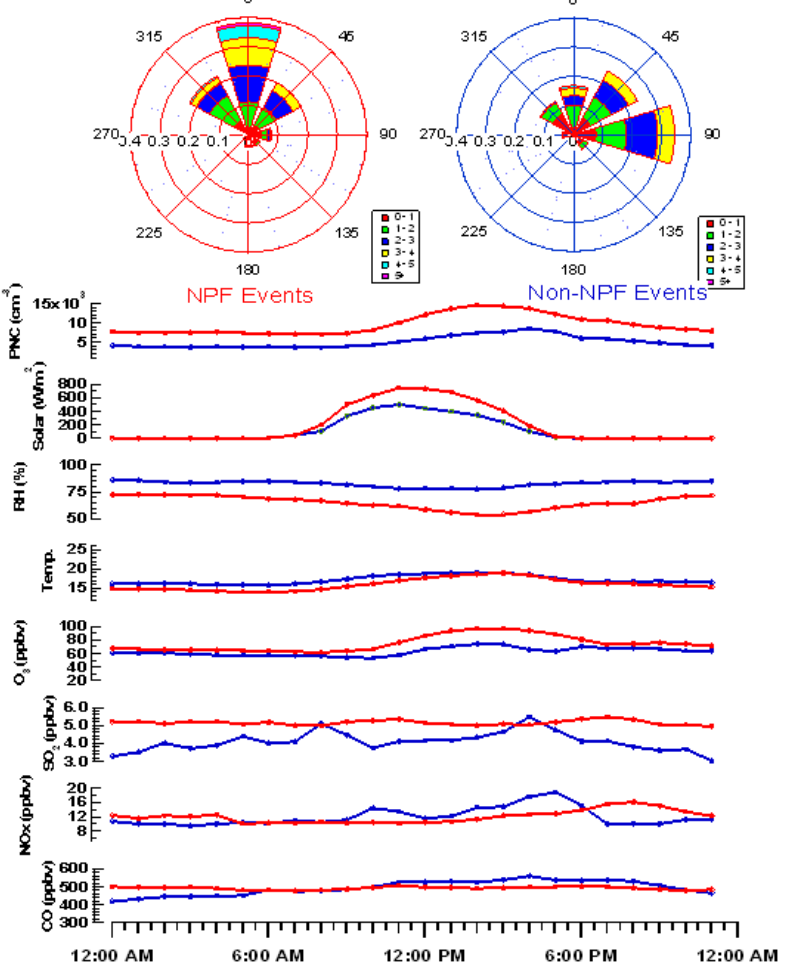
Fig. 2. Average diurnal variations of total PN concentration, trace gases (SO 2 , NO x , CO and O 3 ) and meteorological conditions (solar radiation, RH, T and wind) during NPF event days and non-NPF event days over the whole sampling period at the TMS site. 222